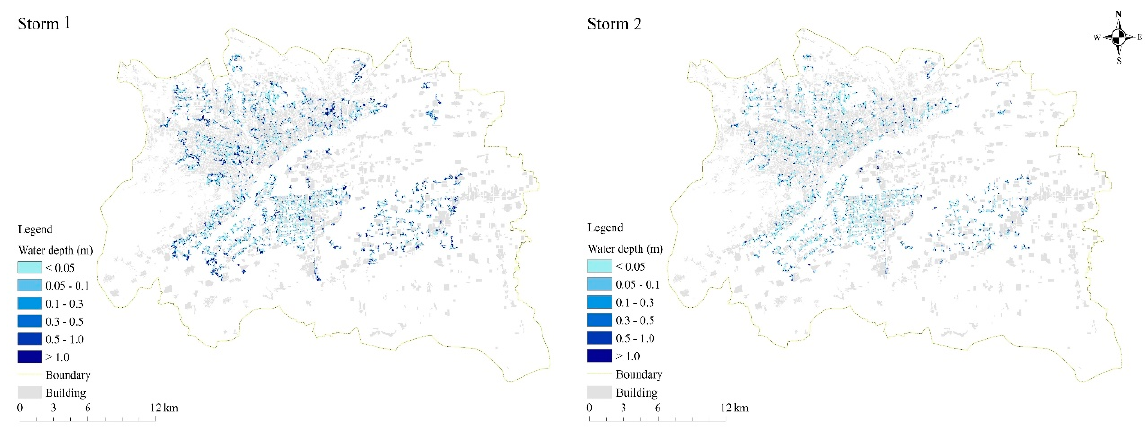
Figure 6. Spatial distributions of inundations from Storm 1 and Storm 2.